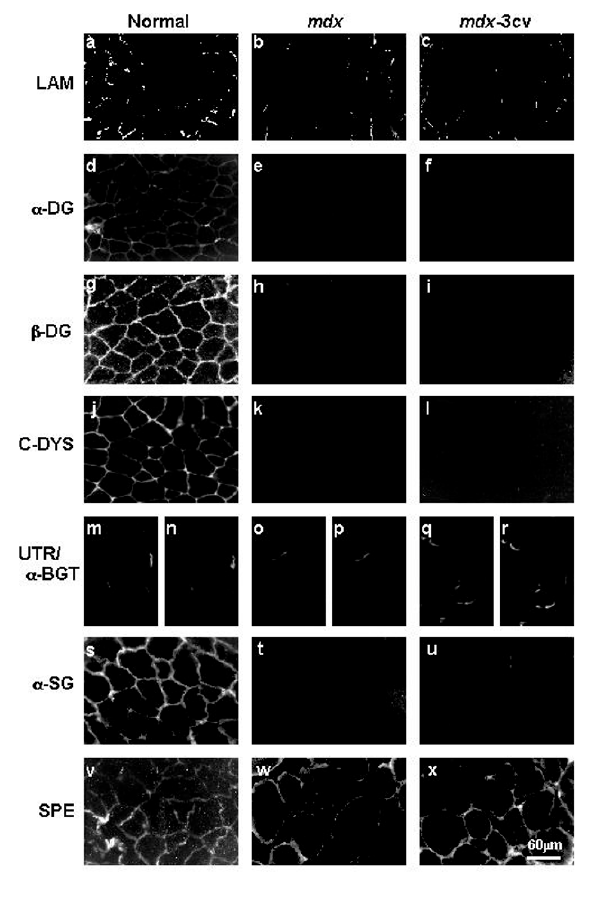
Figure 2 Immunofluorescence localization of β -dystroglycan and associated components in skeletal muscle fibres from dystrophic animal models. Shown are cryosections labeled with antibodies to laminin (LAM) (a-c), α -dystrogly- can ( α -DG) (d-f), β -dystroglycan ( β -DG) (g-i), the carboxy- terminus of dystrophin (C-DYS) (j-l), utrophin (UTR) (m, o, q), α -sarcoglycan ( α -SG) (s-u), and spectrin (SPE) (v-x). Pan- els (n), (p) and (r) represent labeling of tissue sections with α -bungarotoxin ( α -BGT). Skeletal muscle specimens were taken from normal mice (a, d, g, j, m, n, s, v), mdx mice (b, e, h, k, o, p, t, w) and mdx -3cv mice (c, f, i, l, q, r, u, x). Bar = 60 µ